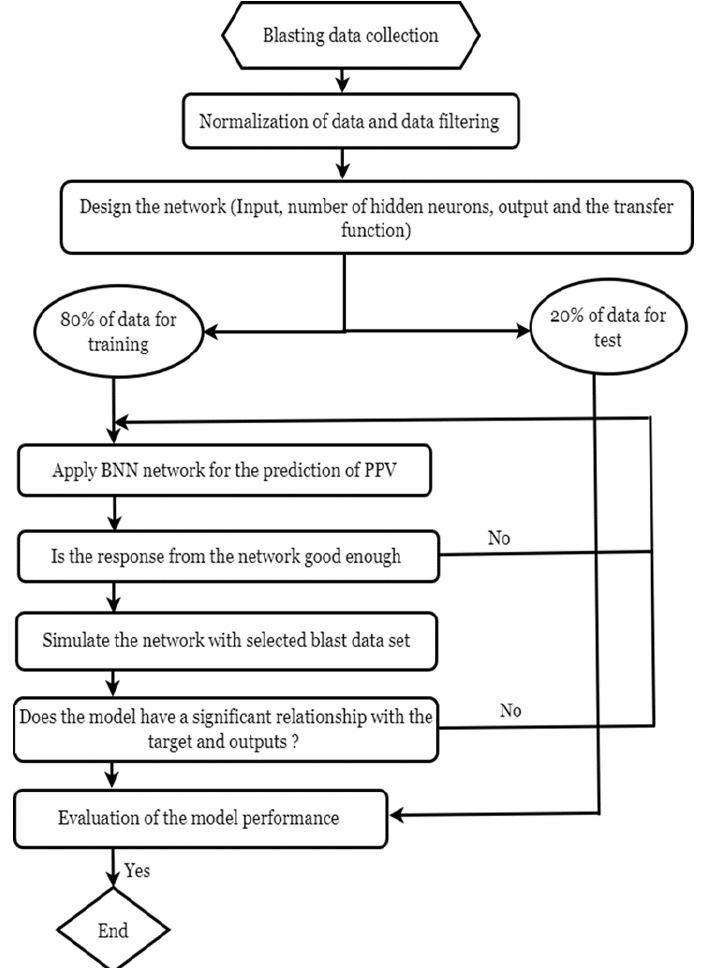
Figure 7. Flow chart of a Bayesian neural network (BNN).